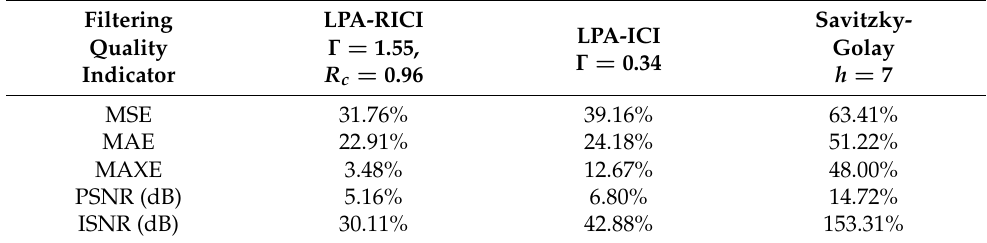
Table 13. Bumps signal (SNR = 10 dB)—Filtering quality improvement of the RBF-RICI-based filtering over other tested